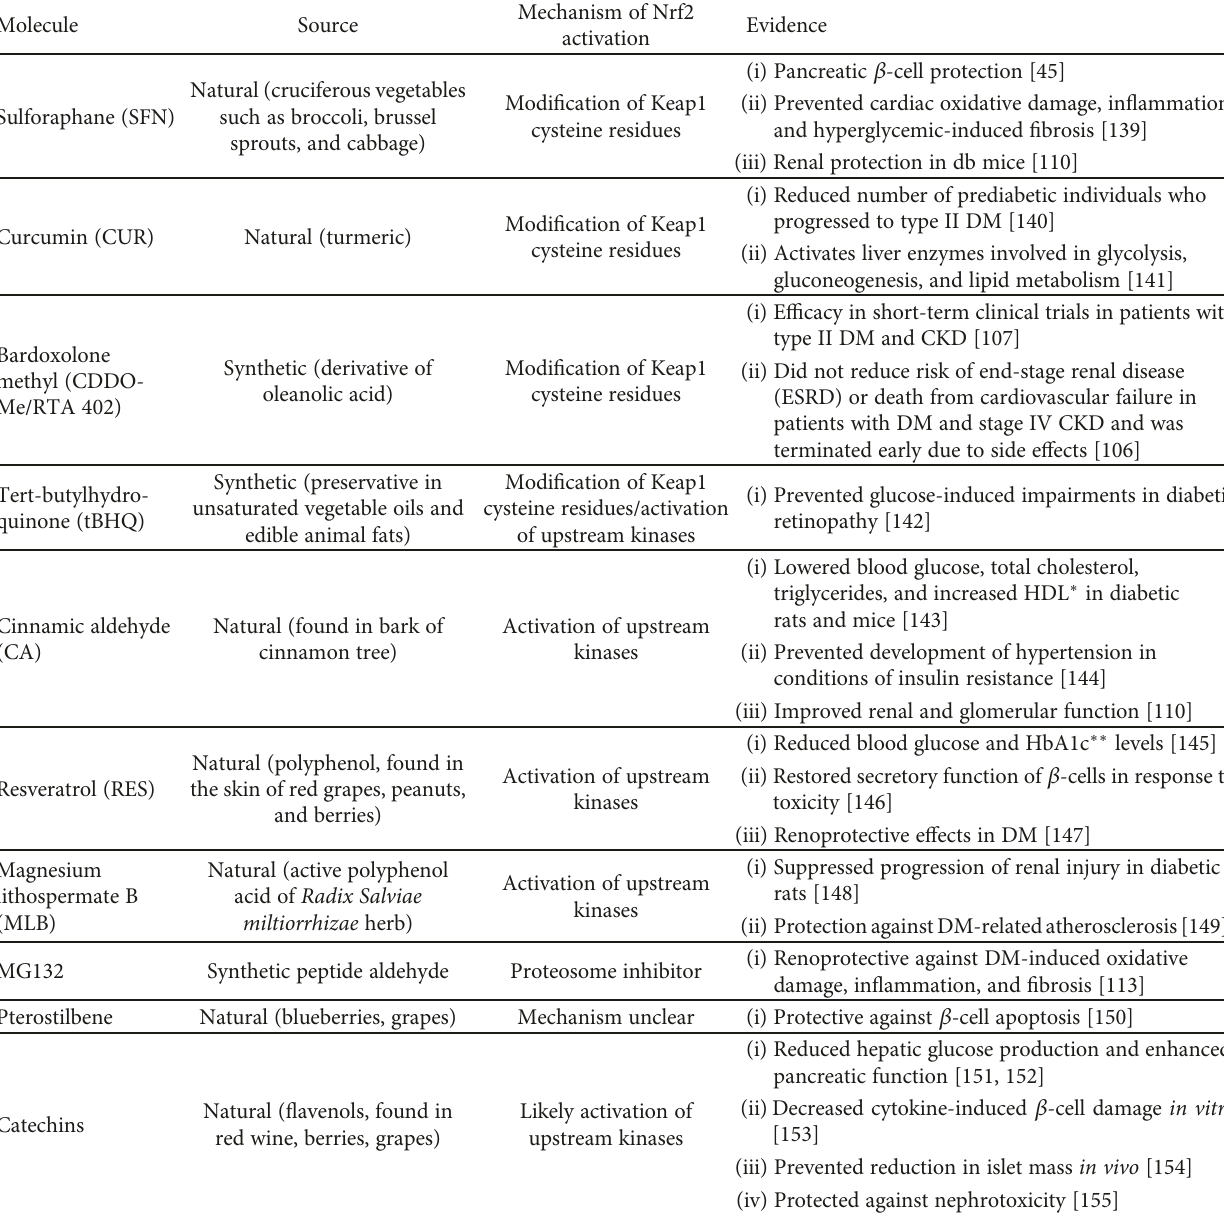
Table 2: Small molecule activators of Nrf2 in